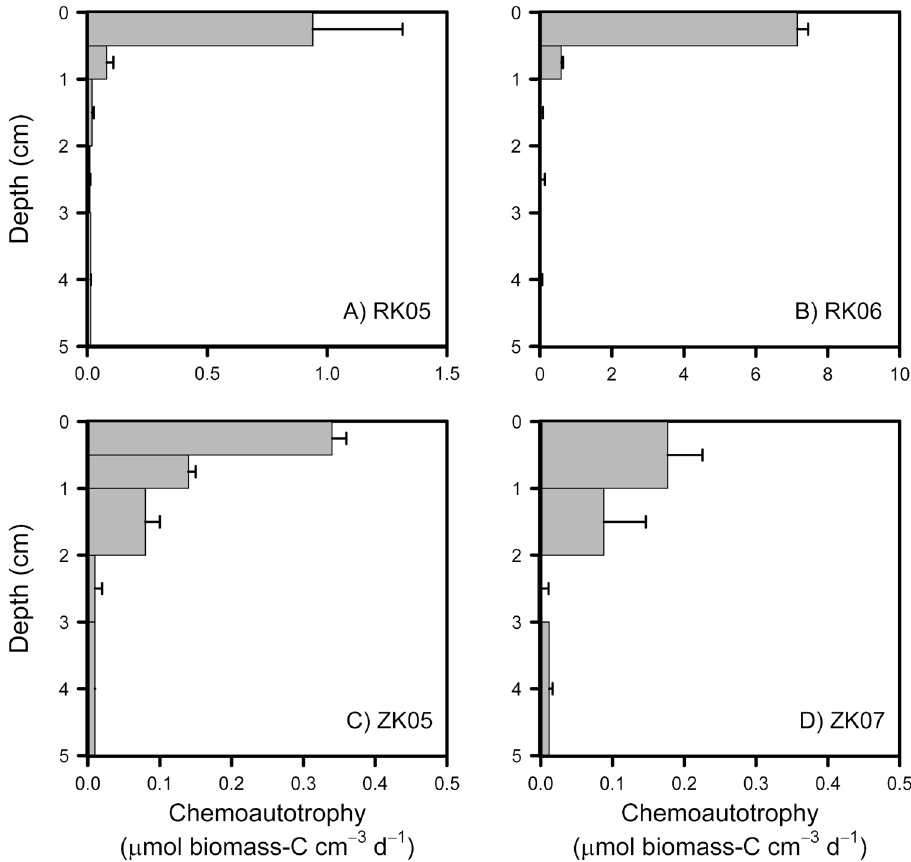
Figure 2. Depth distribution of chemoautotrophy as estimated from 13 C-DIC PLFA labeling in dark incubations for the RK and ZK sediments.